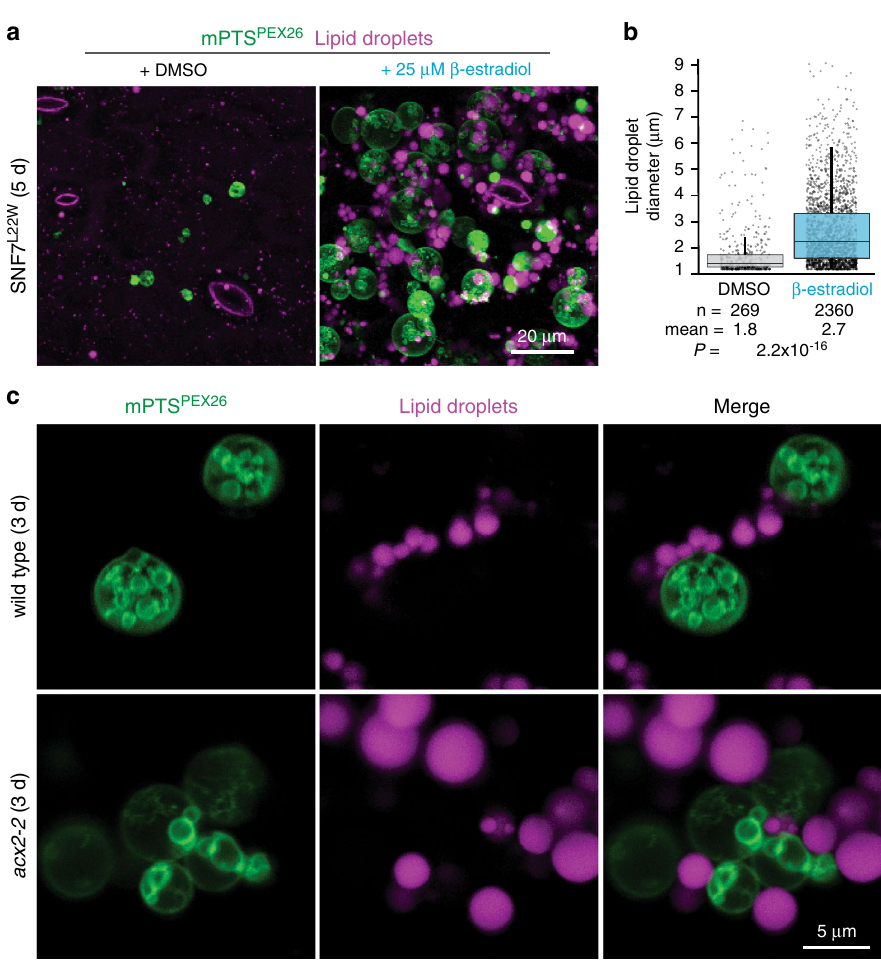
Fig. 5 Peroxisomal vesicles lack engulfed lipid droplets. a Dominant-negative ESCRT induction impairs lipid mobilization. Z -projections of cotyledon epidermal cells of seedlings expressing mNeonGreen-mPTS PEX26 (green) and mRuby3-PTS1 stained with monodansylpentane (MDH) to mark lipid droplets (magenta) and grown with DMSO (mock) or β -estradiol to induce SNF7 L22W expression. b Lipid droplet diameter in SNF7 L22W seedlings from panel ( a ). Boxes show second and third quartiles, horizontal lines are medians, and whiskers encompass data points up to 1.5 times the interquartile range past the box ends. Student ’ s two-tailed unpaired t tests were used to compare lipid droplet size with and without β -estradiol. c Peroxisomal ILVs do not accumulate neutral lipids. Cross-section cotyledon epidermal cells from wild-type or acx2-2 expressing mNeonGreen-mPTS PEX26 (green) and lipid droplets stained with MDH